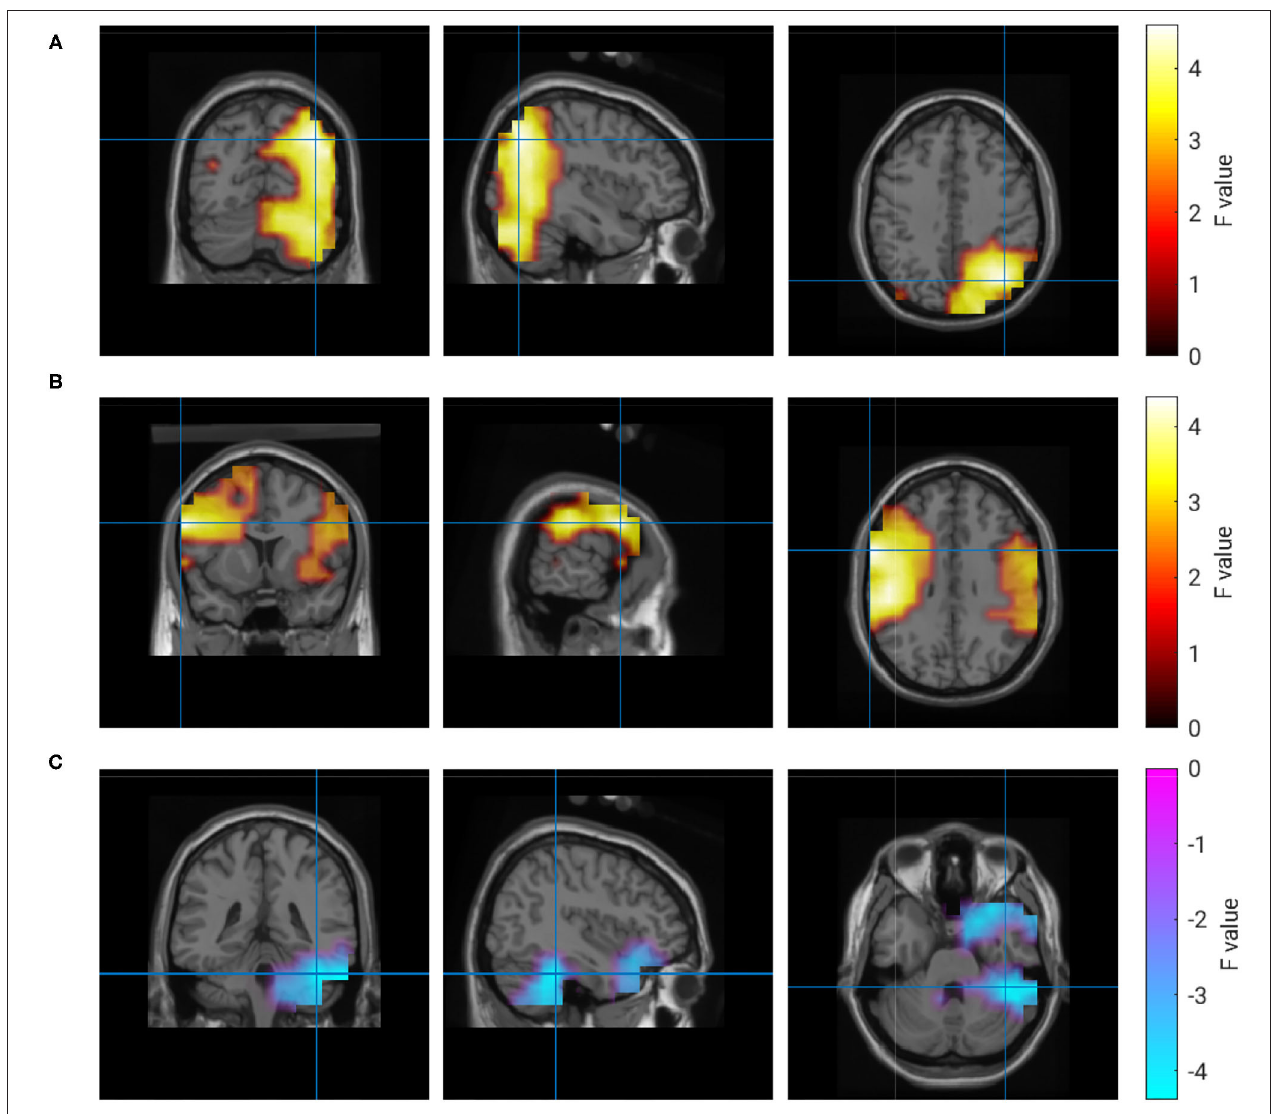
FIGURE 7 | Correlation of brain activity and rating of the partner’s performance. (A) 9 Hz, (B) 20–120 Hz, (C) 1